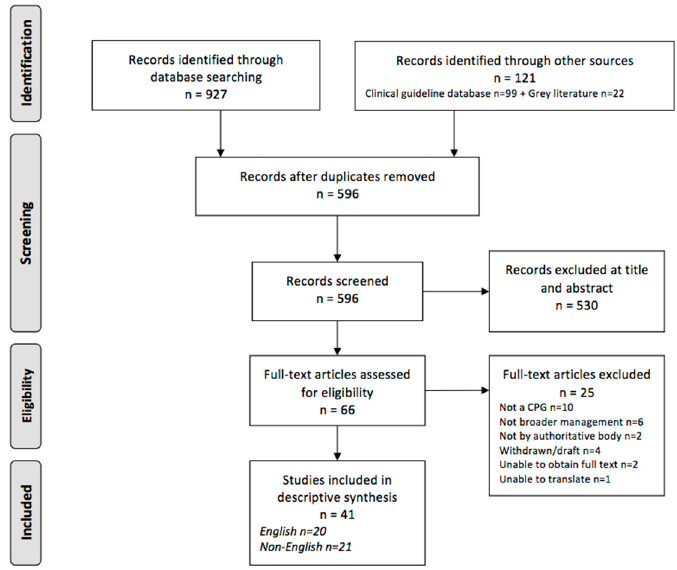
Figure 2. The outcome of the search strategy leading to COPD clinical practice guidelines (CPG) eligible for this review.